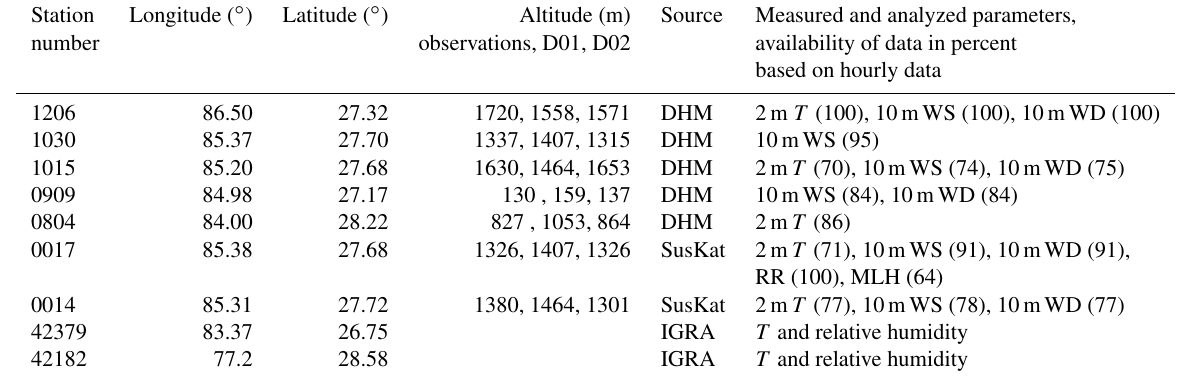
Table 3. Overview and description of the measurement stations ( T indicates temperature, WS indicates wind speed and WD indicates wind direction). DHM indicates the Department of Hydrology and Meteorology of the Ministry of Population and Environment of the Government of Nepal, and IGRA indicates the Integrated Global Radiosonde Archive. MLH indicates mixing layer height.